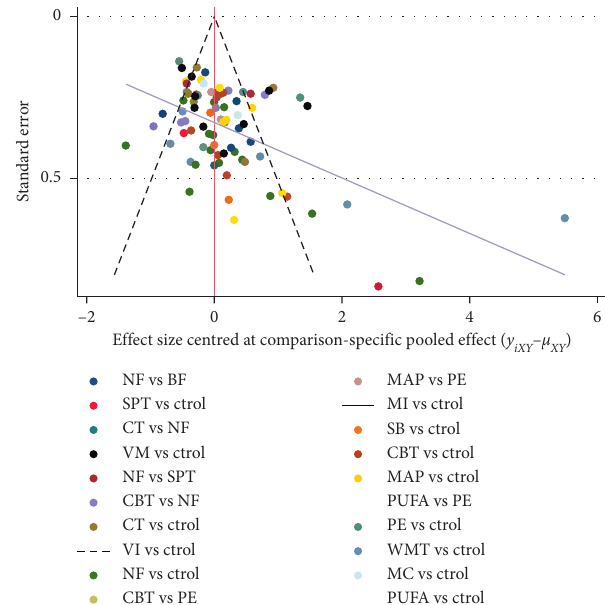
Figure 5: Comparison-adjusted funnel plot and Egger test for each outcome.